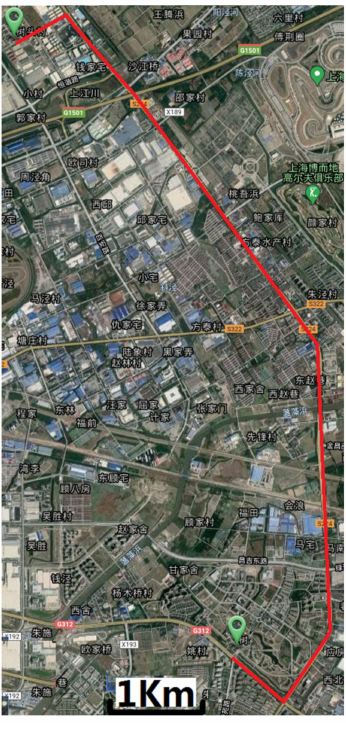
Figure 10. Test route in Google Maps. Table 5. Static disc temperature under normal driving conditions (prudent